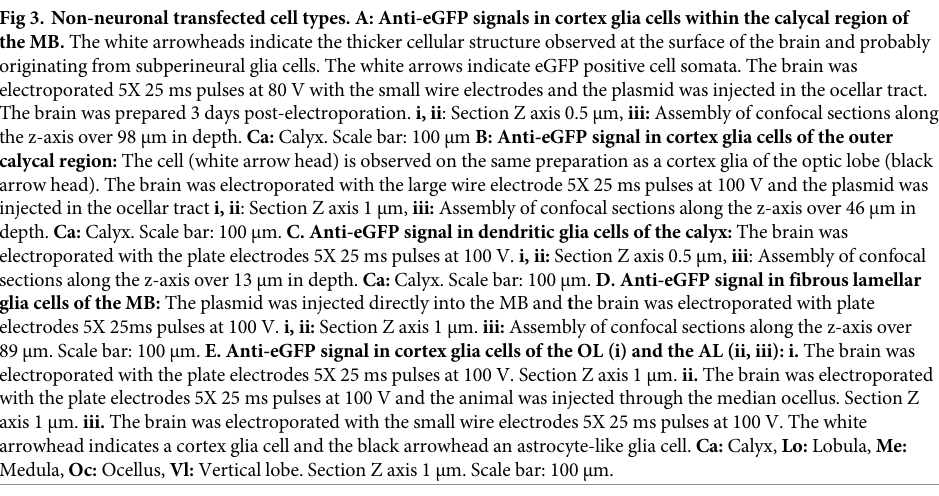
Fig 3. Non-neuronal transfected cell types. A: Anti-eGFP signals in cortex glia cells within the calycal region of the MB. The white arrowheads indicate the thicker cellular structure observed at the surface of the brain and probably originating from subperineural glia cells. The white arrows indicate eGFP positive cell somata. The brain was electroporated 5X 25 ms pulses at 80 V with the small wire electrodes and the plasmid was injected in the ocellar tract. The brain was prepared 3 days post-electroporation. i, ii : Section Z axis 0.5 μ m, iii: Assembly of confocal sections along the z-axis over 98 μ m in depth. Ca: Calyx. Scale bar: 100 μ m B: Anti-eGFP signal in cortex glia cells of the outer calycal region: The cell (white arrow head) is observed on the same preparation as a cortex glia of the optic lobe (black arrow head). The brain was electroporated with the large wire electrode 5X 25 ms pulses at 100 V and the plasmid was injected in the ocellar tract i, ii : Section Z axis 1 μ m, iii: Assembly of confocal sections along the z-axis over 46 μ m in depth. Ca: Calyx. Scale bar: 100 μ m. C. Anti-eGFP signal in dendritic glia cells of the calyx: The brain was electroporated with the plate electrodes 5X 25 ms pulses at 100 V. i, ii: Section Z axis 0.5 μ m, iii : Assembly of confocal sections along the z-axis over 13 μ m in depth. Ca: Calyx. Scale bar: 100 μ m. D. Anti-eGFP signal in fibrous lamellar glia cells of the MB: The plasmid was injected directly into the MB and t he brain was electroporated with plate electrodes 5X 25ms pulses at 100 V. i, ii: Section Z axis 1 μ m. iii: Assembly of confocal sections along the z-axis over 89 μ m. Scale bar: 100 μ m. E. Anti-eGFP signal in cortex glia cells of the OL (i) and the AL (ii, iii): i. The brain was electroporated with the plate electrodes 5X 25 ms pulses at 100 V. Section Z axis 1 μ m. ii. The brain was electroporated with the plate electrodes 5X 25 ms pulses at 100 V and the animal was injected through the median ocellus. Section Z axis 1 μ m. iii. The brain was electroporated with the small wire electrodes 5X 25 ms pulses at 100 V. The white arrowhead indicates a cortex glia cell and the black arrowhead an astrocyte-like glia cell. Ca: Calyx, Lo: Lobula, Me: Medula, Oc: Ocellus, Vl: Vertical lobe. Section Z axis 1 μ m. Scale bar: 100 μ m.